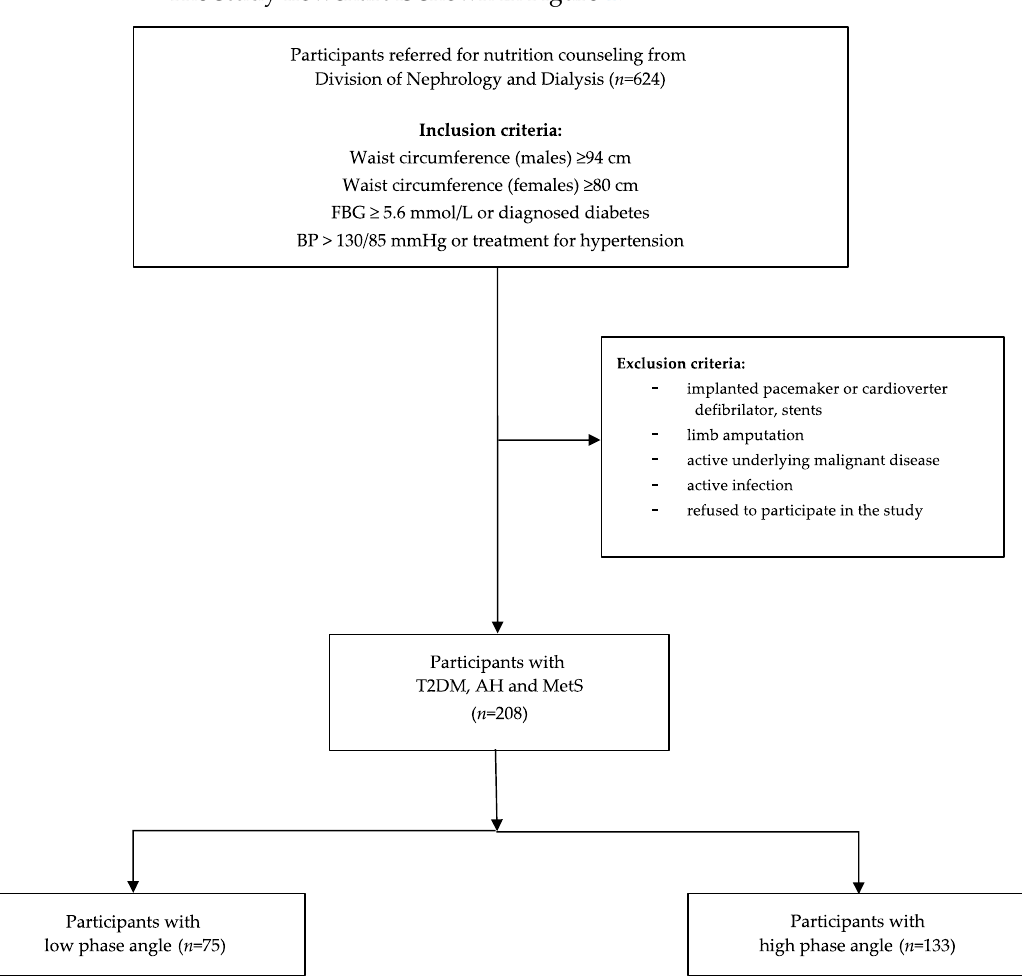
Study Figure 1. Study design . Abbreviations: FBG—fasting blood glucose; BP—blood pressure; T2DM— type 2 diabetes mellitus; AH—arterial hypertension; MetS—metabolic syndrome.